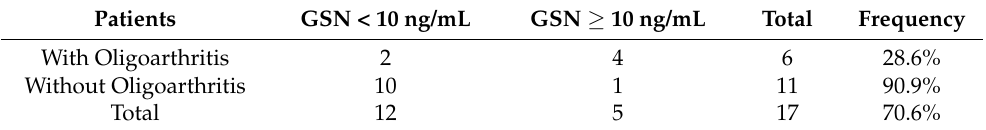
Table 4. Distribution of GSN values among patients with/without JIA oligoarthritis ( n = 17). Patients GSN < 10 ng/mL GSN ≥ 10 ng/mL Total Frequency With Oligoarthritis 2 4 6 28.6% Without Oligoarthritis 10 1 11 90.9% Total 12 5 17